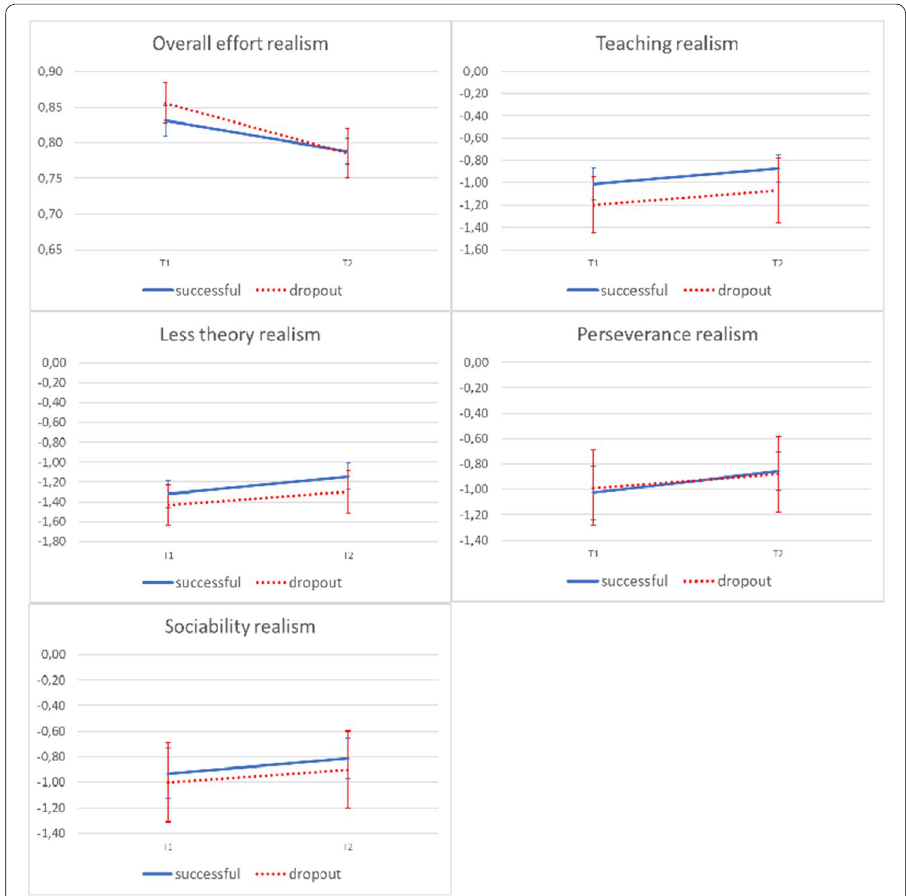
Fig. 2 Change in time of mean realism scores from T1 (start of the program) to T2 (either end of the year or moment of dropout), separately for successful students and dropped out students. Only data form those students are included who filled out the questionnaire twice. Error bars show standard error of the